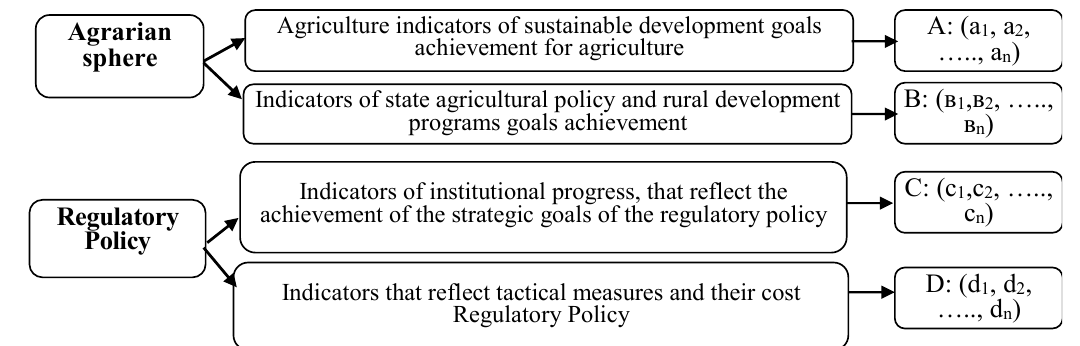
Fig. 3: The structure of the organizational and economic mechanism of regulatory policy effectiveness assessment indicators in agriculture